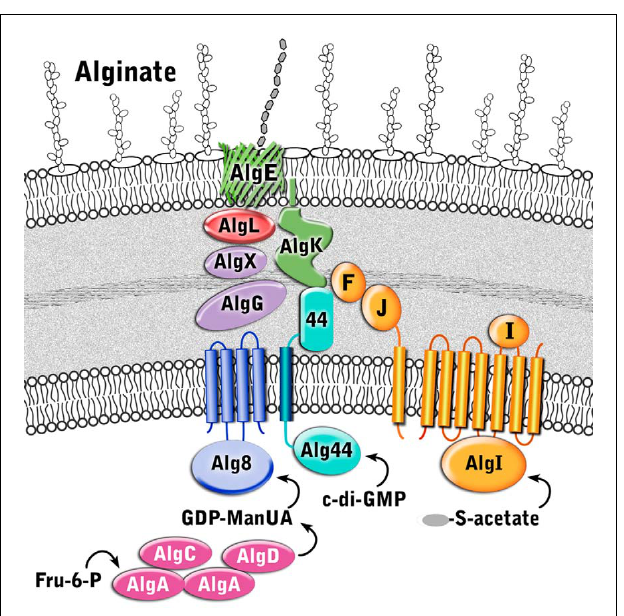
FIGURE 4 | Proposed structure of the alginate biosynthetic complex. The proteins are color coded according to proposed function as described in Figure 3